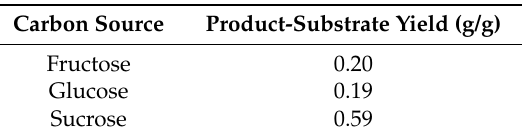
Figure 3. The dynamics of carbon source consumption: Panel ( a ) shows the dynamics of consumption for glucose, fructose and sucrose, each as whole and unique carbon source; panel ( b ) shows a magnified view of the dynamics of consumption of sucrose and its monomeric components, glucose, and fructose. Note that only glucose is consumed after sucrose hydrolysis and the fructose concentration remains the same. Table 1. Product-substrate yield (Y PS ) for each culture medium evaluated. Y PS was calculated as the ratio of dry cellulose produced and substrate consumed during fermentation.